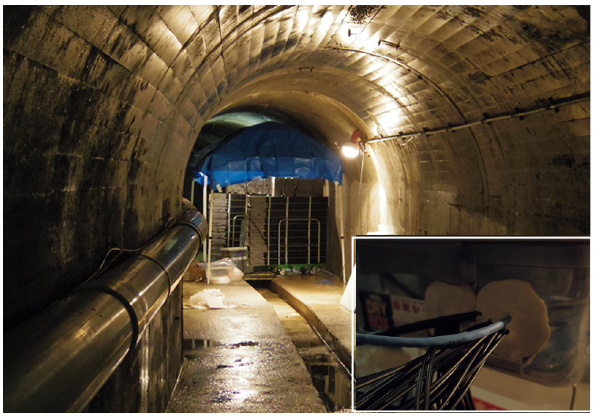
Fig. 6. Photograph of the muon radiography measurement system in the drain tunnel and a housing of the muon readout module (inset).